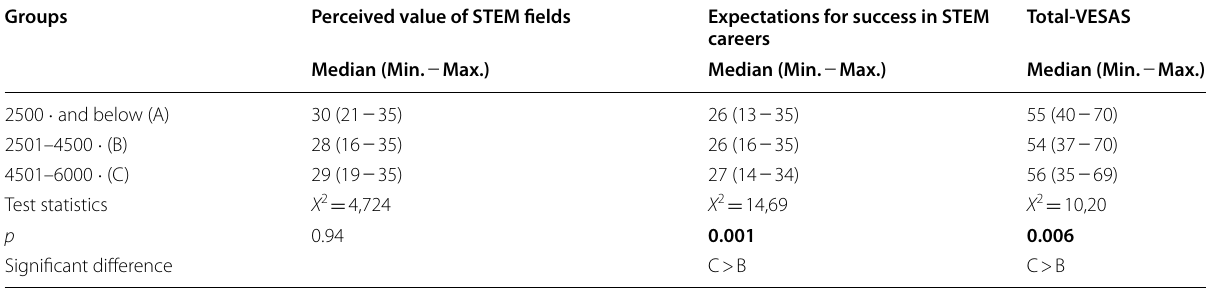
Table 4 The results of Kruskal − Wallis test for participants’ STEM motivation scores according to family income level Groups Perceived value of STEM fields